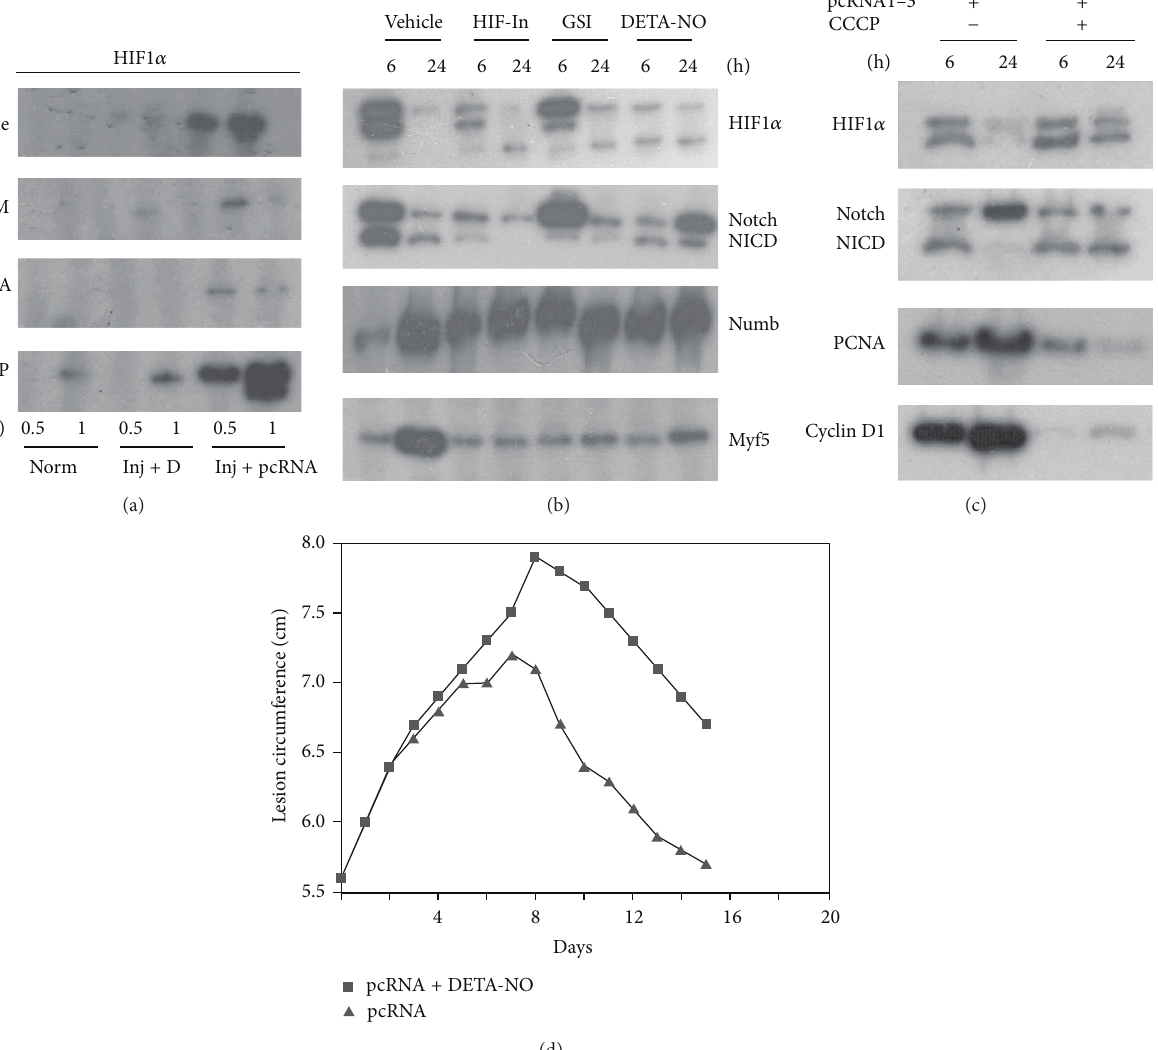
Figure 2: Effect of inhibitors on the hypoxic response and myogenesis. Injured muscle was treated with pcRNA cocktail for the indicated timesinpresenceoftheindicatedinhibitors.CAM,chloramphenicol;AntA,antimycinA;CCCP,m-chlorocarbonylcyanidephenylhydrazone; HIF-In, HIF inhibitor; GSI, 𝛾 -secretase inhibitor; DETA-NO, diethylenetriamine/nitric oxide adduct. (a–c) Western blots were probed with antibody against the indicated proteins. (d) The lesion size was measured in presence or absence of DETA-NO.